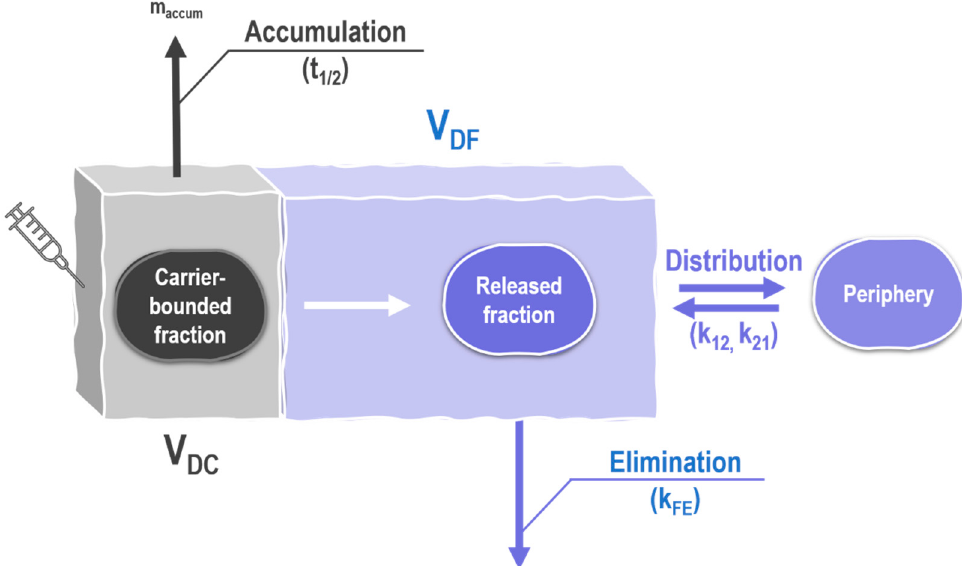
Figure 6. Illustration of the PBNB model. The model is composed of three main compartments representing the carrier-bound (grey) and the released fraction of the drug including the distribution into one periphery compartment (violet).